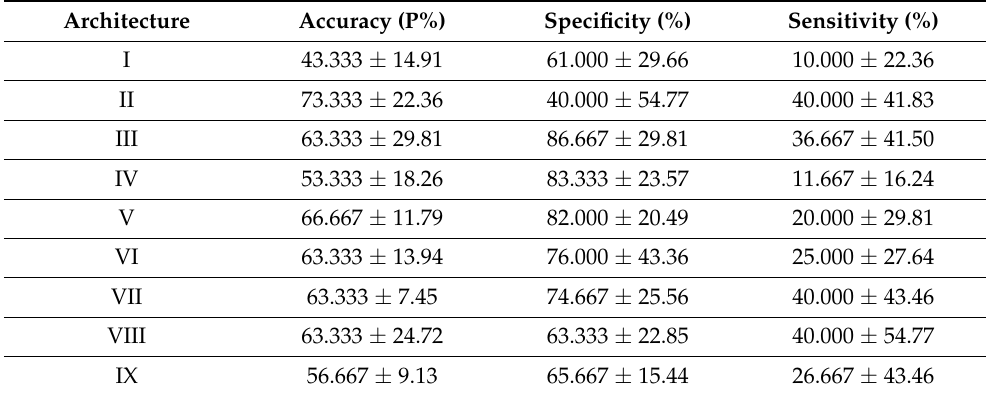
Table 5. II architecture’s confusion matrix: the diagonal elements, highlighted in red, correspond to the number of correctly classified entries (True Positive = 85% and True Negative = 40%). The off- diagonal elements correspond to wrong classifications, False Negative and False Positive.